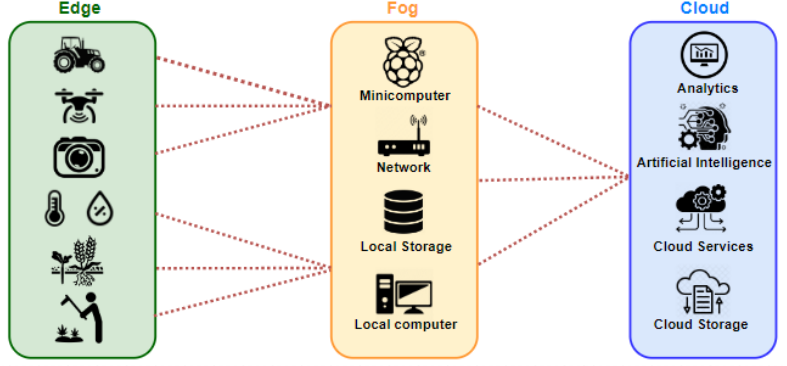
Figure 1. Types of computation (adapted from